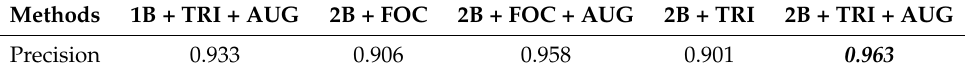
Table 3. Precision of compared methods on the RobotCar Intersection data fused with images generated by rain and haze models.